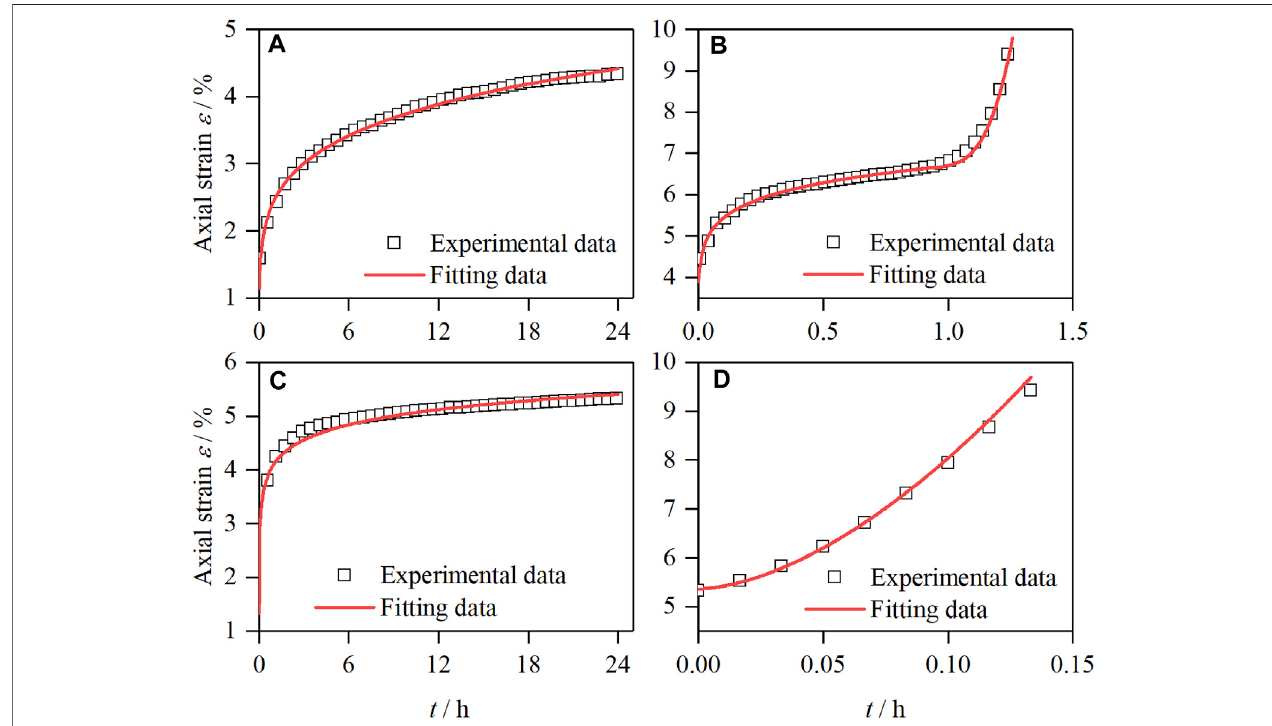
FIGURE 12 | Fitting curve of unloading con fi ning pressure in steps with constant principal stress. (A) Stress state at point A. (B) Stress state at point B. (C) Stress state at point C. (D) Stress state at point D.